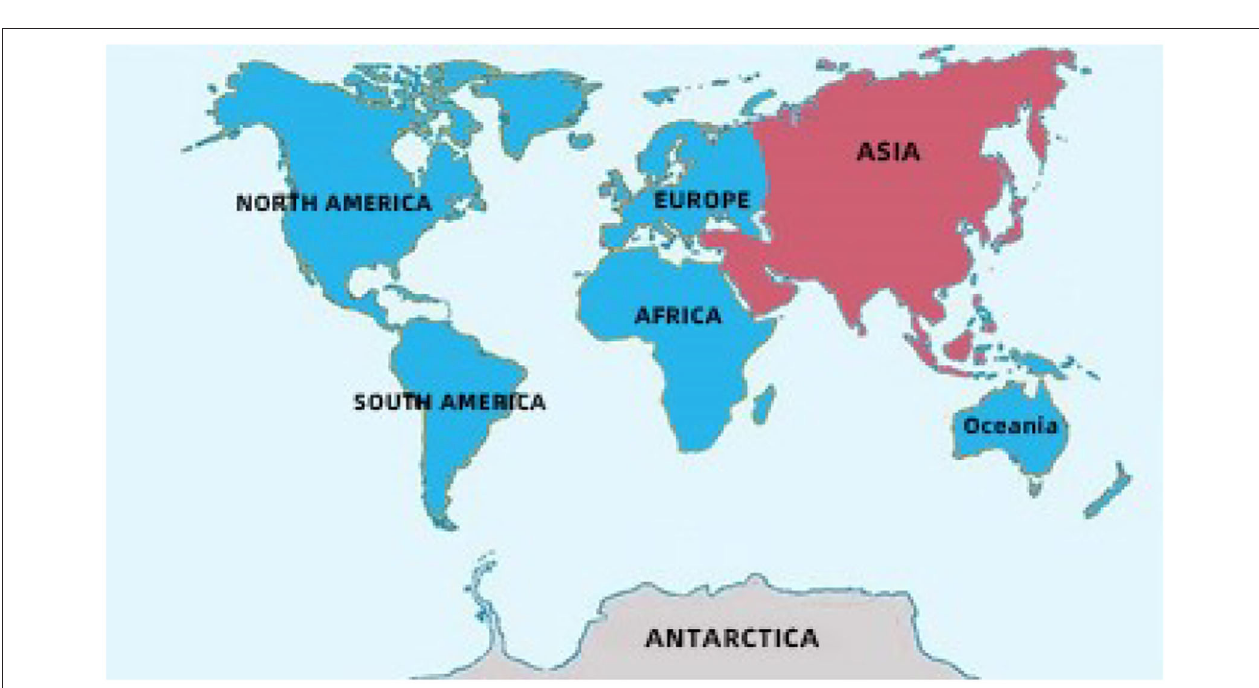
FIGURE 1 | The main geographical distribution of kinds of vinegar in the world. Blue: The main producing areas of fruit kinds of vinegar. Red: The main producing areas of cereal kinds of vinegar.